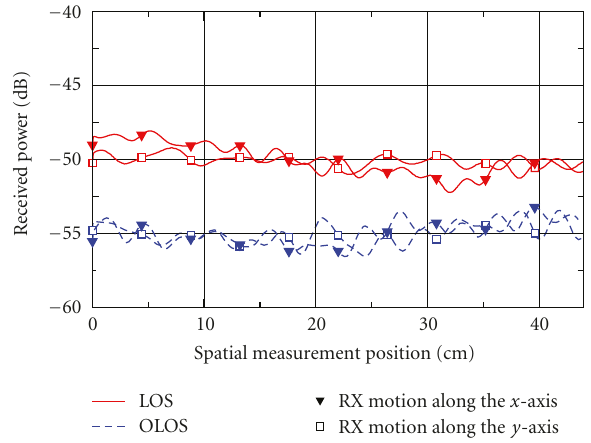
Figure 10: Received power of SISO channel averaged over the frequency domain data at each spatial measurement